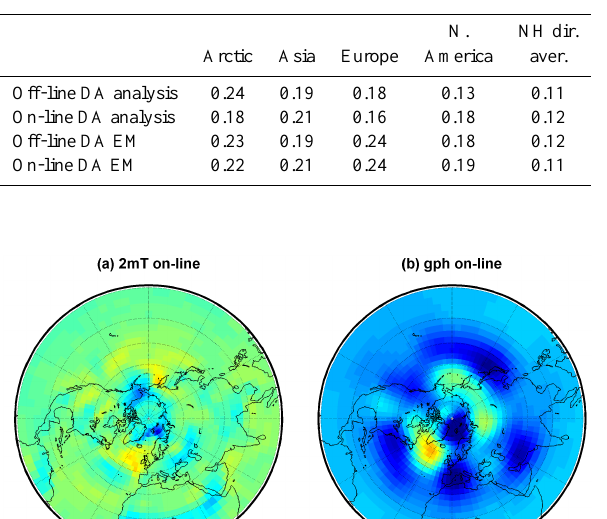
Table 4. Standard deviations of the ensemble spreads for the North- ern Hemisphere of the two data assimilation schemes, calculated for all the years and for the final year of each